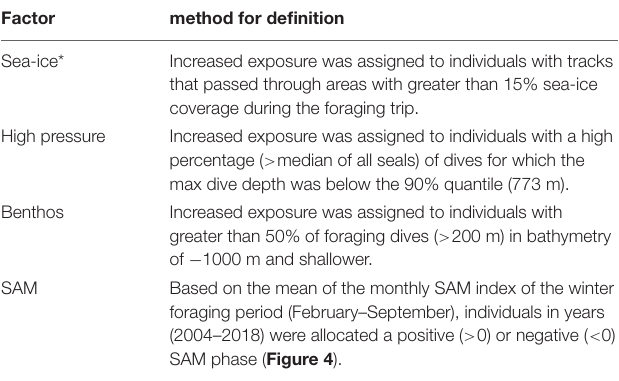
TABLE 1 | Explanatory variables proposed to influence tag failure